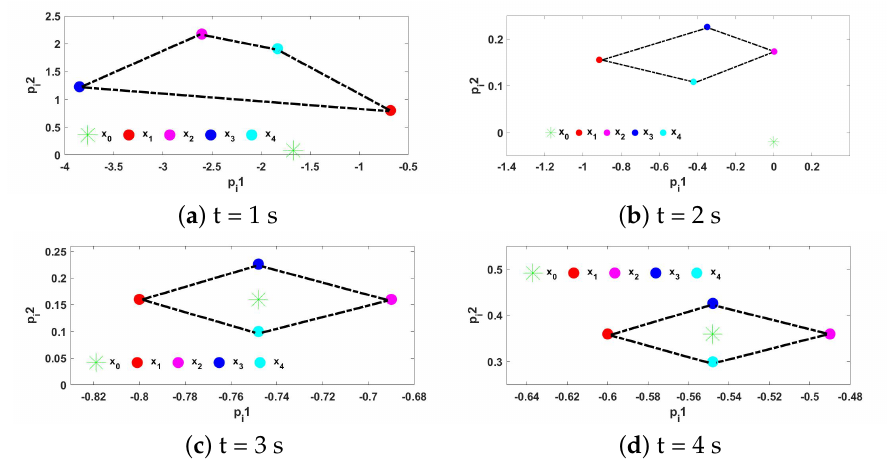
Figure 12. States trajectory snapshots of agents at different